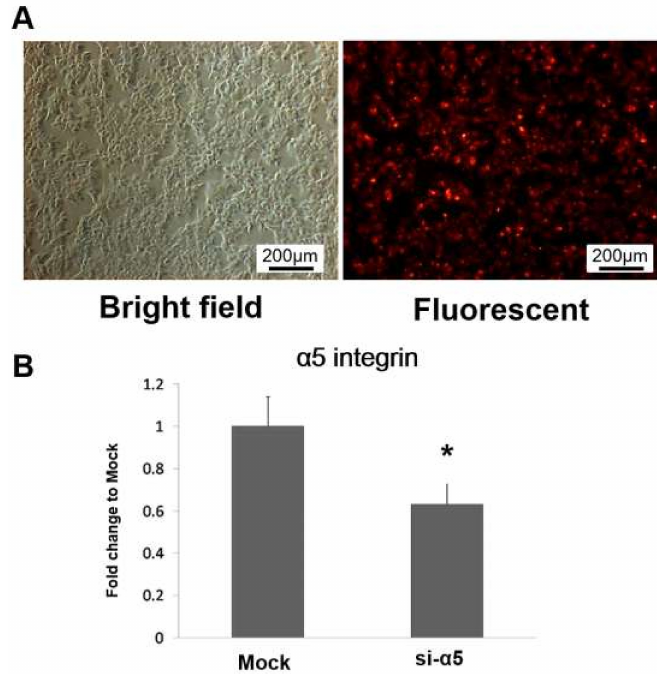
Figure 5. α 5 integrin siRNA silencing using Lipofectamine. ( A ) Phase-contrast image and a fluorescent image of D1 cells (passage 9) after Alexa Fluor Red transfection (scale bars = 200 µ m). ( B ) α 5 integrin mRNA expression levels in D1 cells transfected with nonspecific control oligonucleotides (mock group) or α 5 integrin-specific siRNA (si- α 5 group) after culture in basal medium for 3 days. The α 5 integrin mRNA expression level in the si- α 5 group is expressed relative to that in the mock group, which is defined as 1. The values are presented as the mean ± SD ( n = 3), * p < 0.05 in comparison to the mock